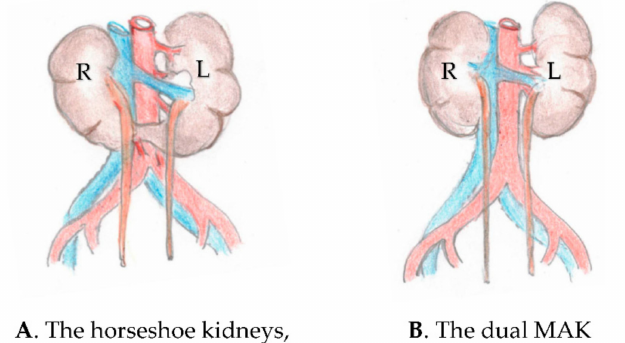
Figure 1. Schematic drawing showing the similarity of ( A ) the horseshoe kidneys with the transverse isthmus slightly above the level of the aortic bifurcation, and ( B ) the en bloc dual adult kidneys. The horseshoe kidneys are located 1–2 vertebras below the regular kidneys. Note the multiple segmental renal arteries and the arteries to the isthmus arising from the iliac arteries. In both drawings, the vena cava is on the left side of the aorta. R = right kidney, L = left kidney.